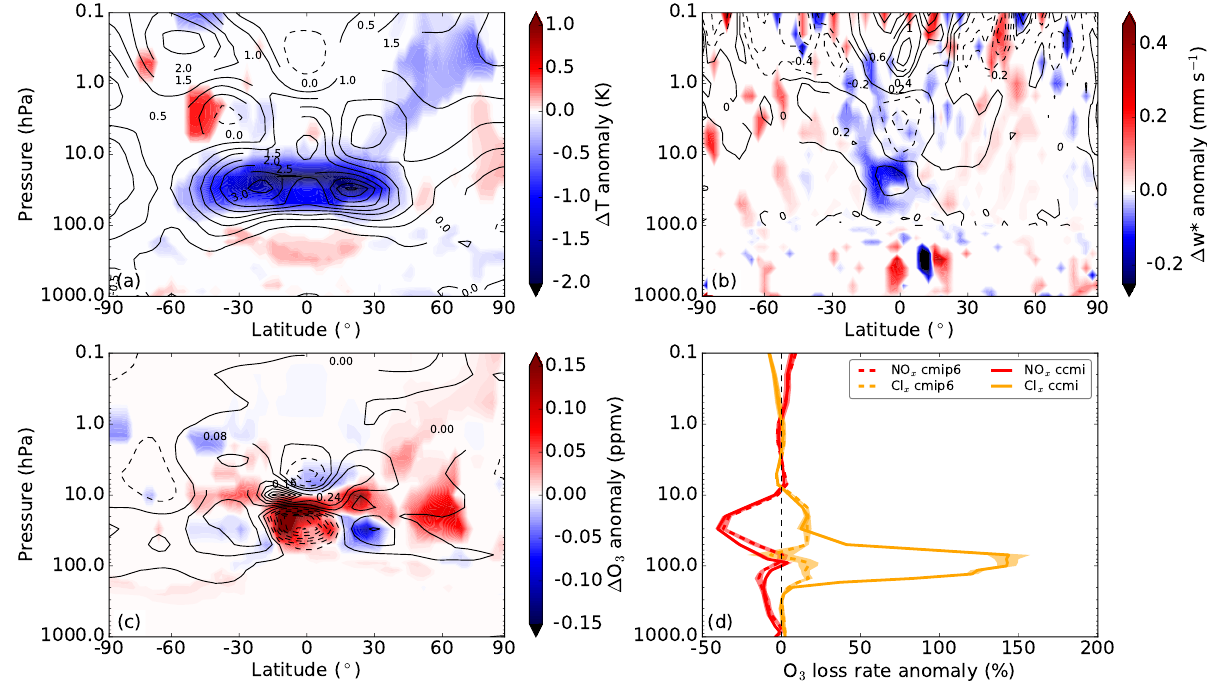
Figure 3. Differences in ensemble-mean, zonal-mean anomalies averaged over the 6 months following the Mt Pinatubo eruption between the ensembles using CMIP6 and CCMI aerosol (CMIP6 minus CCMI). For the contour plots (a–c) , regions that are not statistically significant at the 95% level of confidence (as calculated with Student’s t test, p < 0 . 05) are set to zero. (a) Difference in temperature anomalies (red/blue shading). For reference, the black contours represent the CCMI anomalies over the same period, i.e. the red/blue shading from Fig. 2a. (b) As (a) but showing anomalies in the vertical residual circulation. (c) As (a) but showing ozone anomalies. (d) As Fig. 2d but showing anomalies in the tropical ozone destruction rates for only the NO x and Cl x ozone destruction cycles in the CMIP6 and CCMI